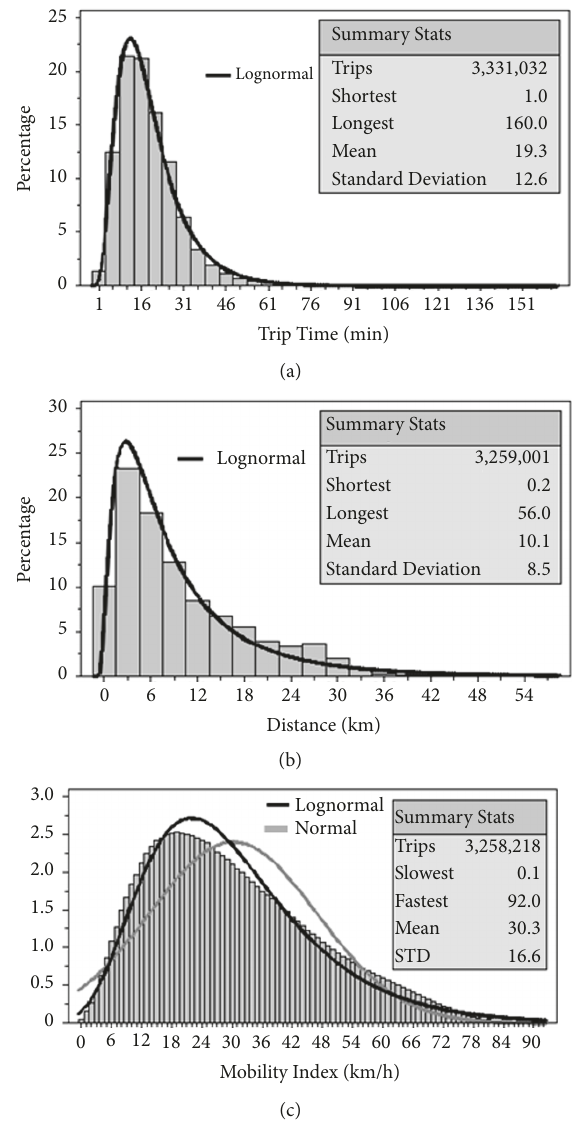
Figure 2: Distribution of trip times, distances, and mobility indices after